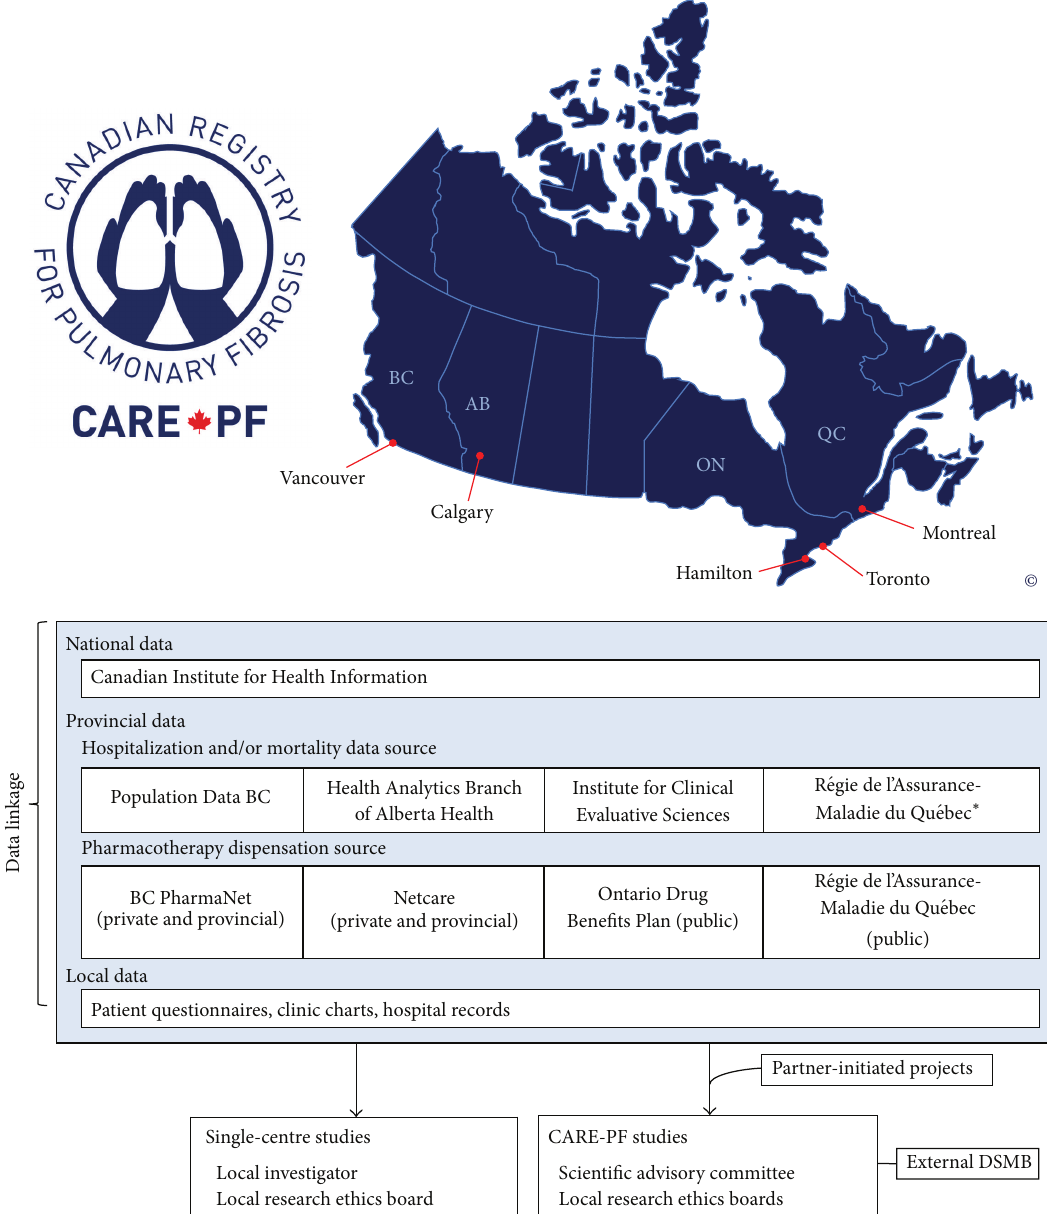
Figure 1: CARE-PF data sources and organizational structure. Copyright owned by the CARE-PF investigators. ∗ means Qu´ebec healthcare utilization data are available only for patients who are ≥ 65 years of age or on